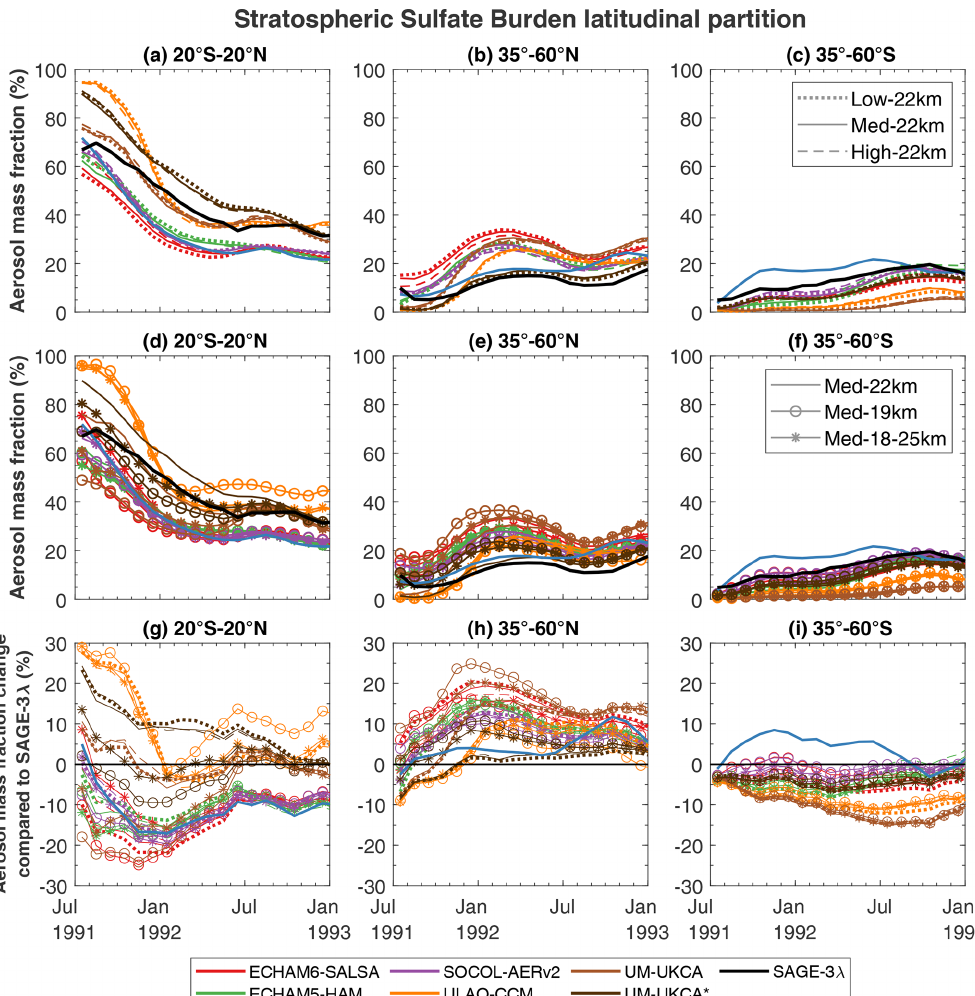
Figure 7. Time evolution of the latitudinal partition of the stratospheric sulfate burden. The aerosol mass fraction is calculated with respect to the total burden, for the tropical burden (20 ◦ N–20 ◦ S) (a, d g) , for the burden integrated over the northern mid-latitudes (35 ◦ –60 ◦ N) (b, e, h) , and for the burden integrated over the southern mid-latitudes (35 ◦ –60 ◦ S) (c, f, i) . The first row includes the experiments with different amounts of SO 2 injected, the second row experiments with different injection altitudes. The third shows the percentage change in the latitudinal partition for all model experiments compared to SAGE-3 λ . Experiments are identified here with different line styles; the different colors refer to the models. ∗ Models with spatially spread SO 2